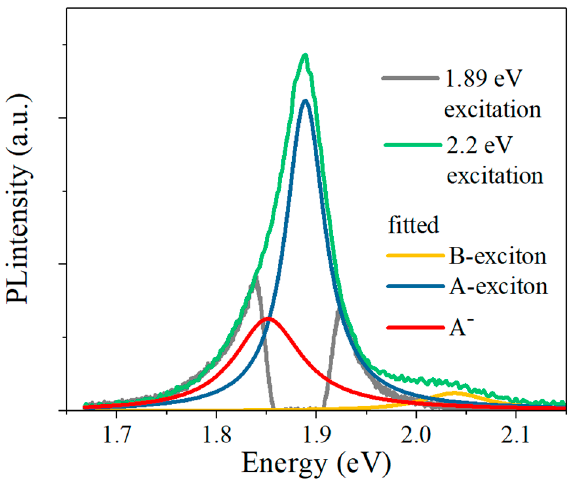
Figure 13. PL spectra of anomalous MoS 2 bilayer with off-resonant and resonant excitation. PL spectrum with off-resonant 2.2 eV excitation is rescaled and fitted for direct comparison. No emission of B-exciton can be observed under 1.89 eV excitation of A-exciton resonance. A - , trion.